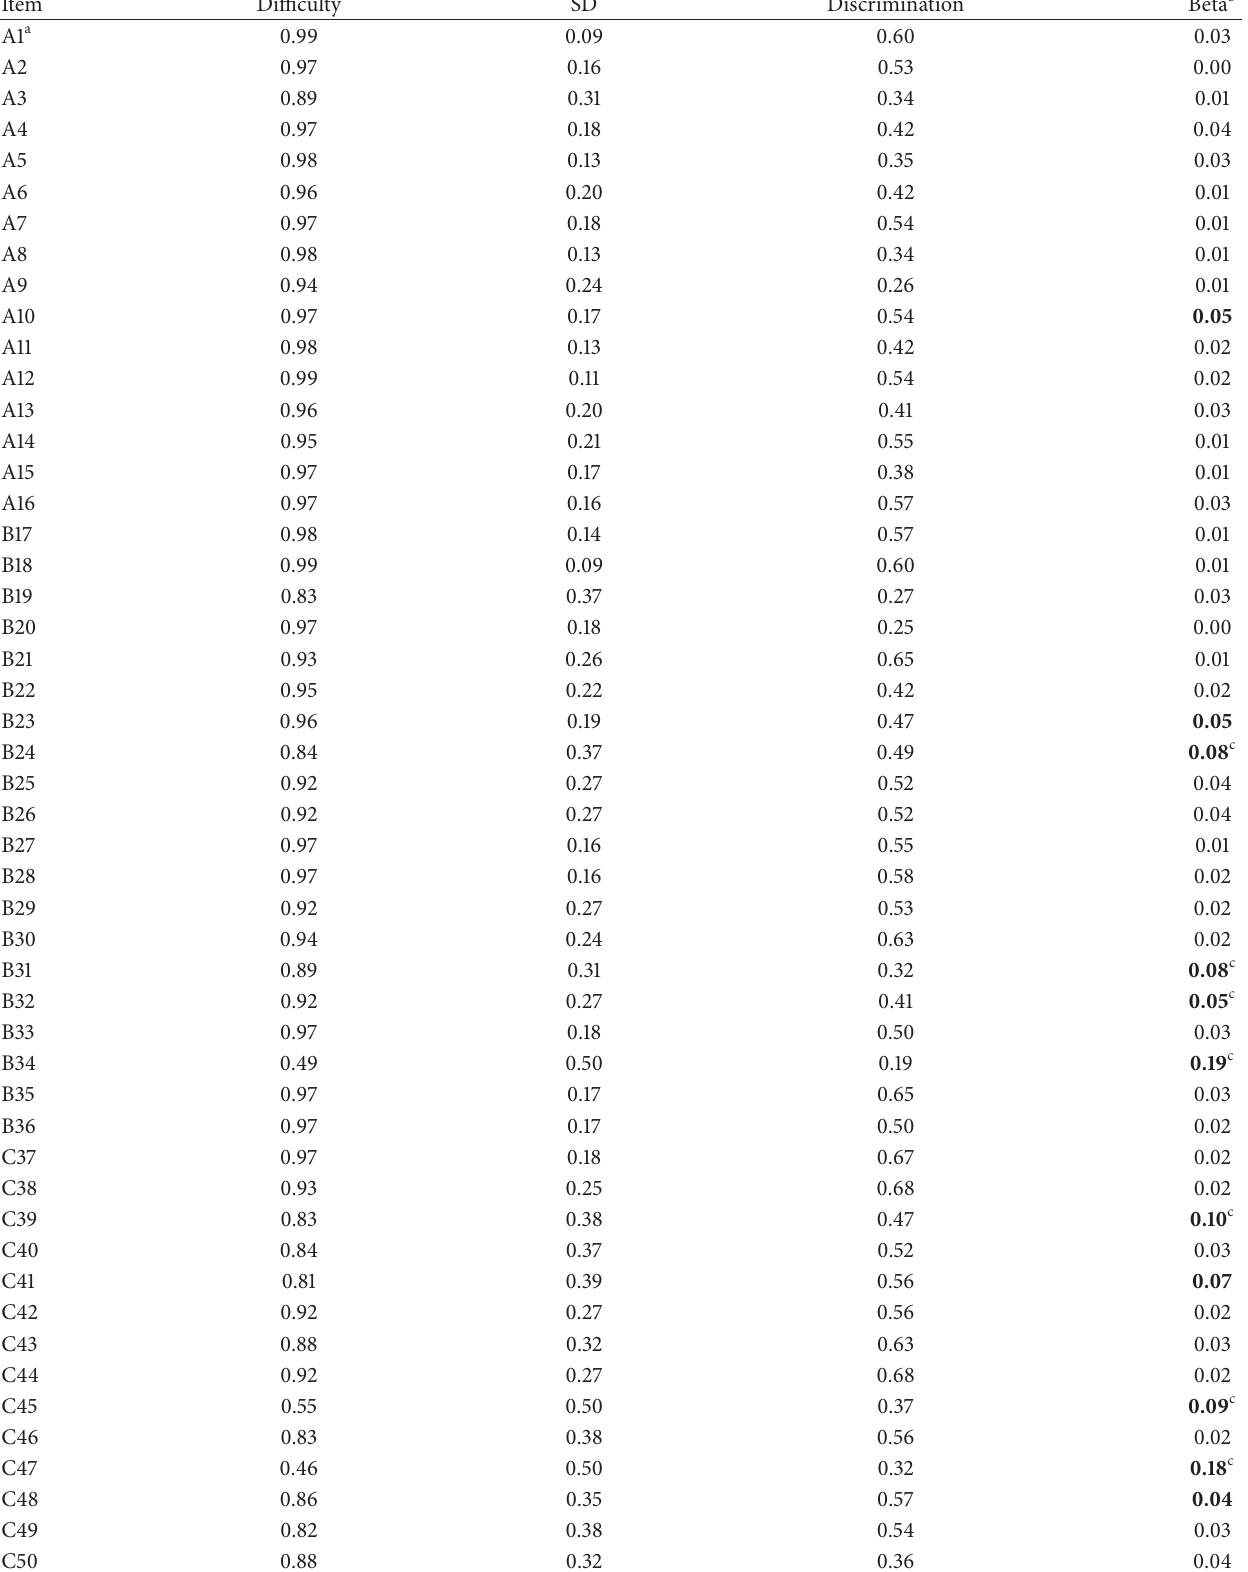
Table 2: Item difficulties, discriminations, and